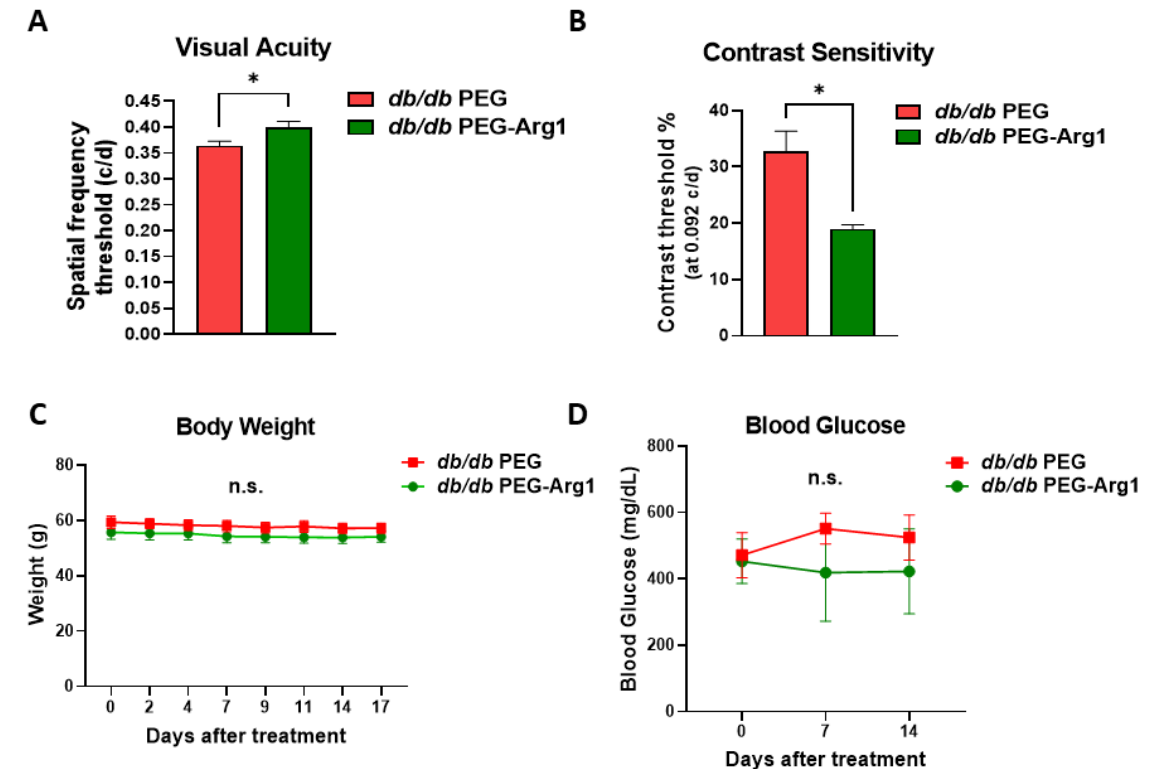
Figure 2. PEG-Arg1 treatment improves the visual function of db/db mice without affecting body weight or random blood glucose. ( A , B ) The db/db mice that received the PEG-Arg1 treatment showed improved visual acuity and contrast sensitivity compared with the PEG-treated db/db mice (n = 3 per group with * p < 0.05). ( C ) No significant differences appeared in the body weight of db/db mice treated with 25 mg/kg/dose of either PEG-5000 (control) or PEG-Arg1 thrice weekly for 2 weeks. ( D ) Randomly collected blood glucose levels showed no significant change with PEG-Arg1 treatment. Data are presented as the mean ± SEM.